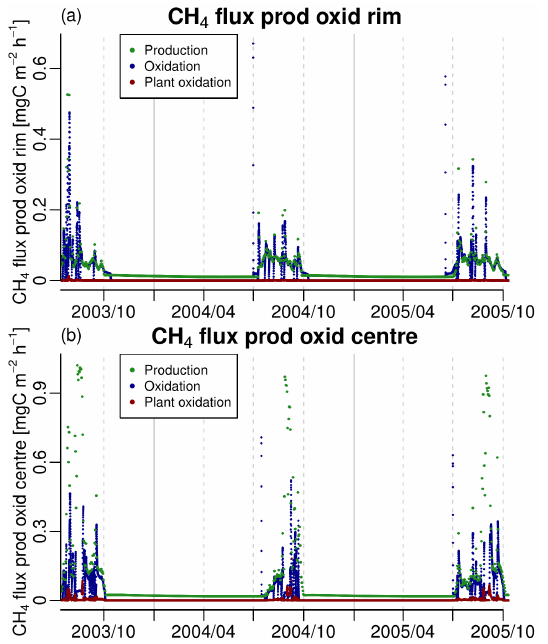
Figure 5. Modelled methane amounts that get produced and oxi- dised at the (a) rim and (b) centre, split into the different processes. Solid lines indicate 1 January; dashed lines indicate 1 April, 1 July and 1 October of the respective year. Please note the different scales. The maxima of the values are 0.670 (a) and 1.02 (b) mgCm − 2 h − 1 . Table 2. Change in the cumulative methane emissions over the modelled time period in %, when the parameter was modified by ± 10% compared to its default setting.